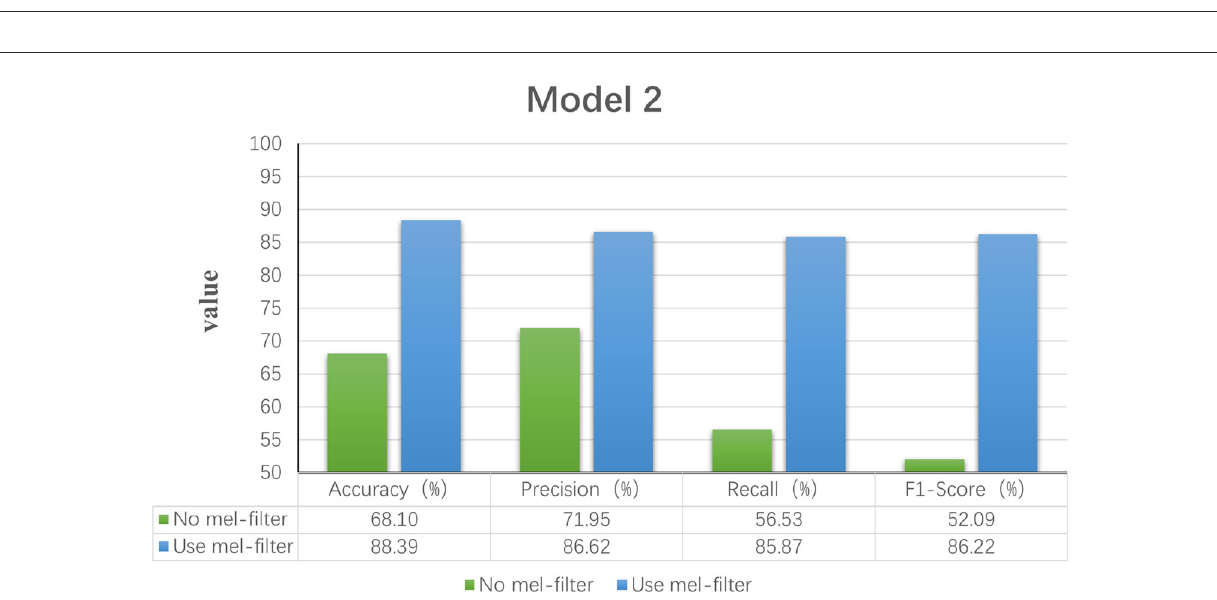
FIGURE3 Statistical graphs of the evaluation results of the model with the addition of FT vs. without FT.